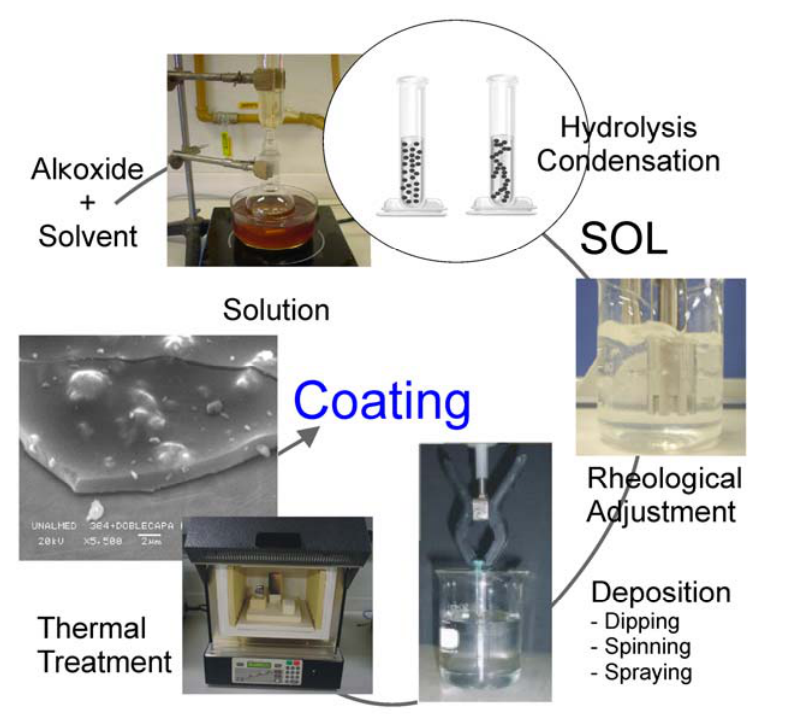
Figure 2. Sol-gel